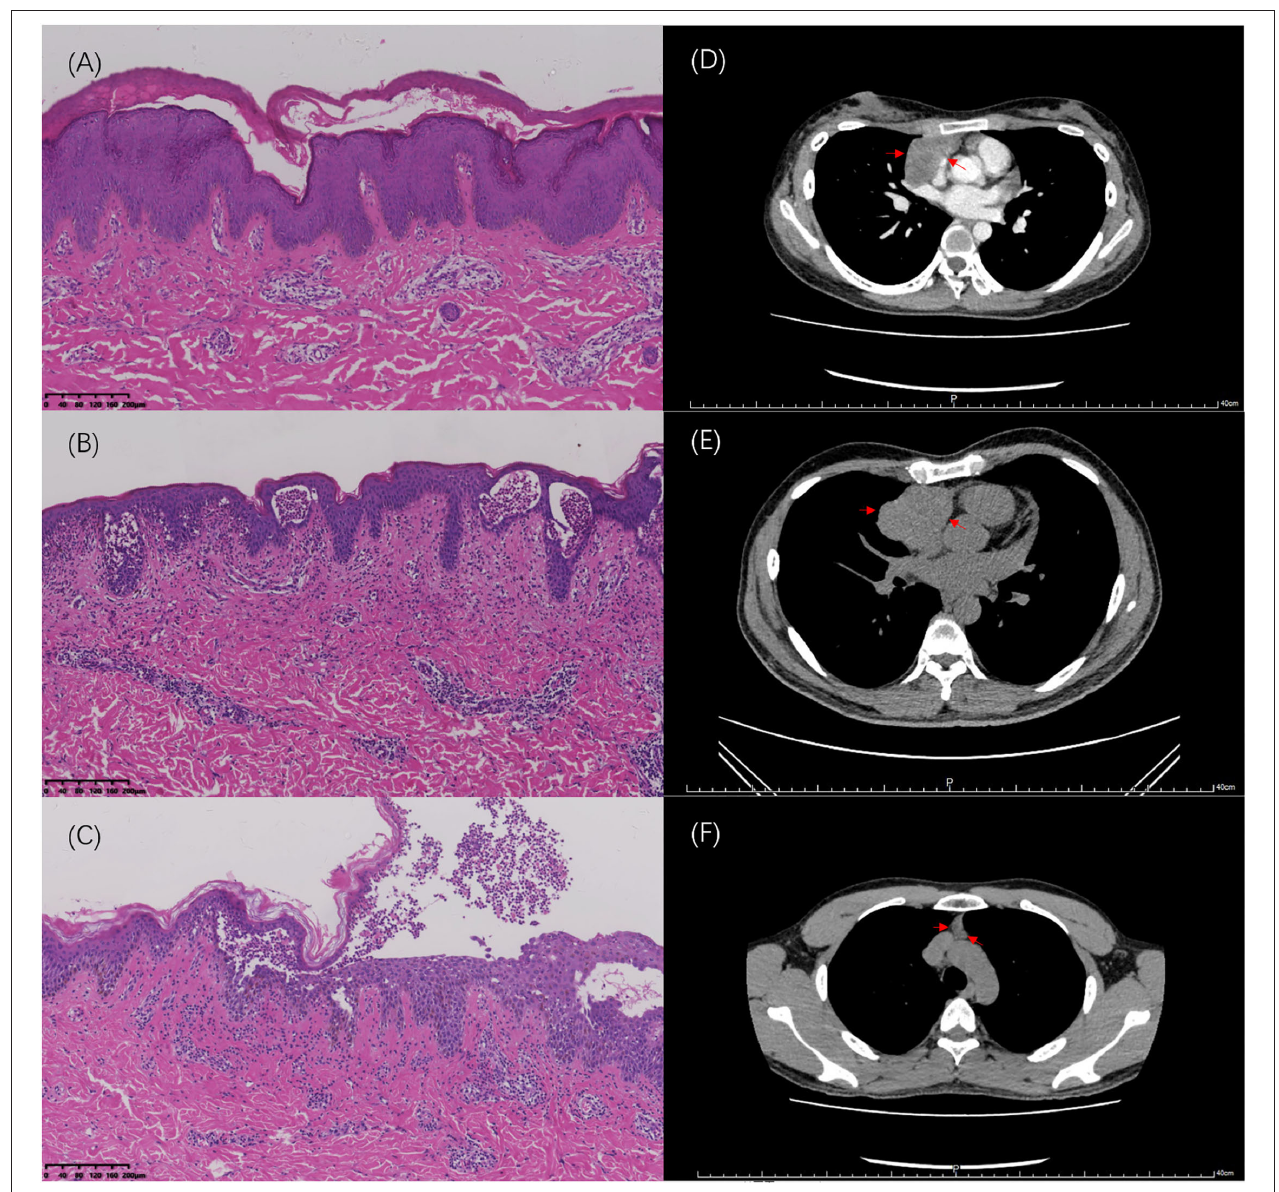
FIGURE 2 | Hematoxylin and eosin (HE) stained sections of skin lesions (100 × ) and imaging changes of the thymus. (A) Case 1: Formation of substratum corneum fissures is observed. (B) Case 2: Blisters in the epidermis are filled with neutrophils. (C) Case 3: Bullous formation in the epidermis with acantholysis cells is visible. (D) Thymic imaging via CT scan for Case 1 at first hospitalization. (E) Thymic imaging via CT scan for Cases 2 before surgery. (F) Thymic imaging via CT scan for Case 3 at 2 years after his first